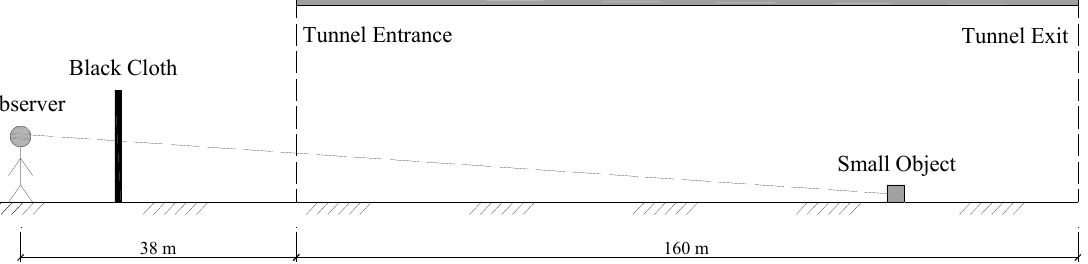
Figure 6. Acquisition of a driver’s pupil diameter data. ( a ) Eye tracker, ( b ) the driver wearing eye tracker. Figure 5. Visible distance test for a small object in tunnel.